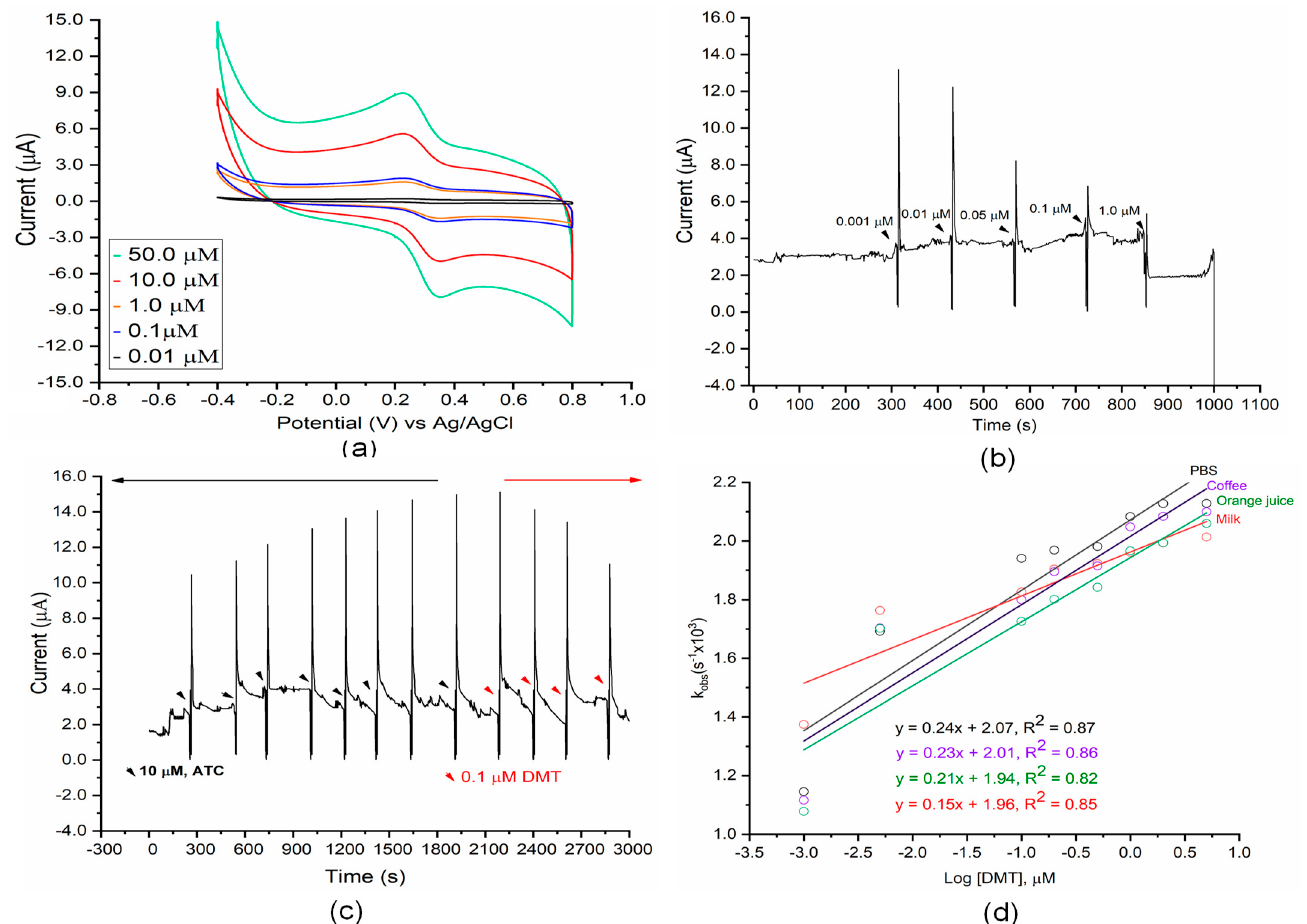
Figure 5. Electrochemical assay of DMT-inhibited AChE assays. ( a ) Cyclic voltammograms of the fluidic biosensor in presence of different concentrations (0.01–1.0 µ M) of DMT. ( b ) Amperometric responses of the composited electrode for DMT analysis. (Flow rate: 100 µ L/min; working potential: 150 mV). ( c ) shows the decreased activity of AchE due to the fixed substrate ATC (10 µ M) (left) and accumulated DMT (0.1 µ M) in the fluidic biosensor (right). Amperometric assay with a potential of 150 mV on the composited sensor. The assay was run in the phosphate buffer (10 mM, pH 8.0) mixed with 0.1 M KCl. ( d ) pseudo-first-order rate constant as a function of DMT concentration in different spiked samples (Equation (6)).